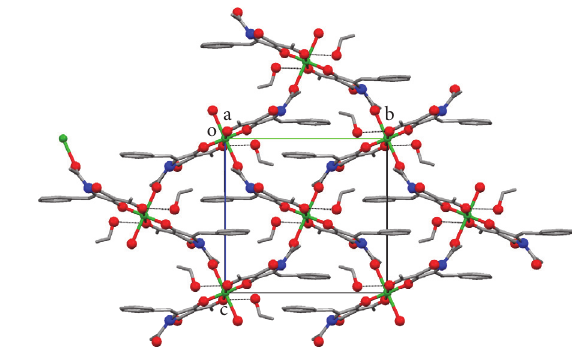
Figure 2: Part of the polymeric sheet structure parallel to the 𝑎 -axis. Hydrogen bonds shown as dashed lines; hydrogen atoms omitted for